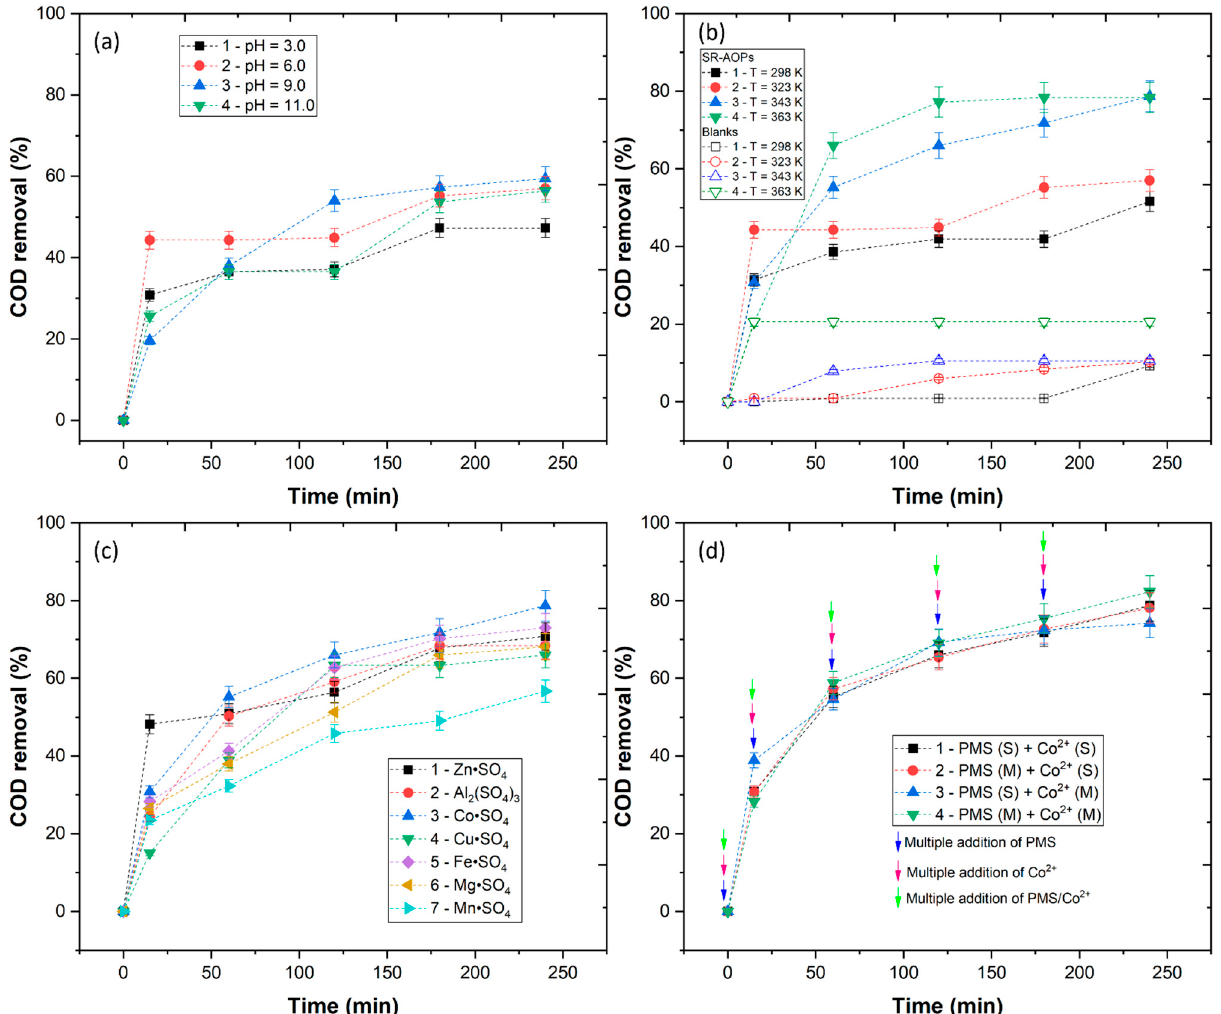
Figure 5. COD removal in the optimization of ( a ) pH ([PMS] = 5.88 mM, [Co 2+ ] = 5 mM, radiation UV-A, T = 323 K), ( b ) temperature (SR-AOPs: pH = 6.0, [PMS] = 5.88 mM, [Co 2+ ] = 5 mM, radiation UV-A; blanks: pH = 6.0, radiation UV-A), ( c ) type of metal catalyst (pH = 6.0, [PMS] = 5.88 mM, [ M n+ ] = 5 mM, radiation UV-A, T = 343 K) and ( d ) dosing of PMS and Co 2+ . S—single addition, M—multiple addition (pH = 6.0, [PMS] = 5.88 mM, [Co 2+ ] = 5 mM, radiation UV-A, T = 343